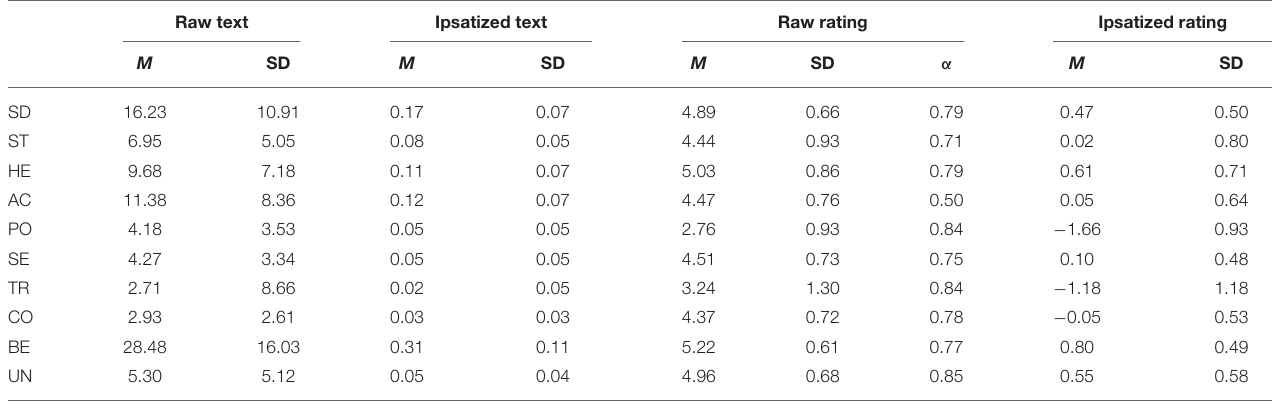
TABLE 5 | Overall value means for different data types and score adjustments in Study 2. Raw text Ipsatized text Raw rating